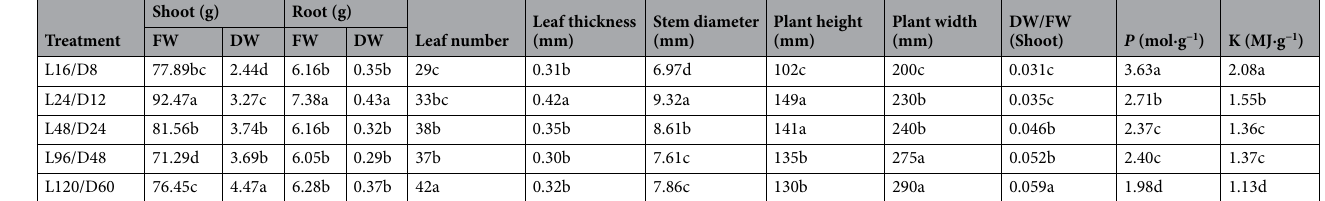
Table 1. Biomass, morphological parameters, and consumption for producing per unit weight of lettuce exposed to different L/D cycle treatments of RB. Values for the same parameter with different letters significantly differ at the 5% level (by Tukey’s test, n = 3). FW fresh weight, DW dry weight, p the number of photons required to produce 1 g of weight, K the electricity consumed to produce 1 g of weight. L/D